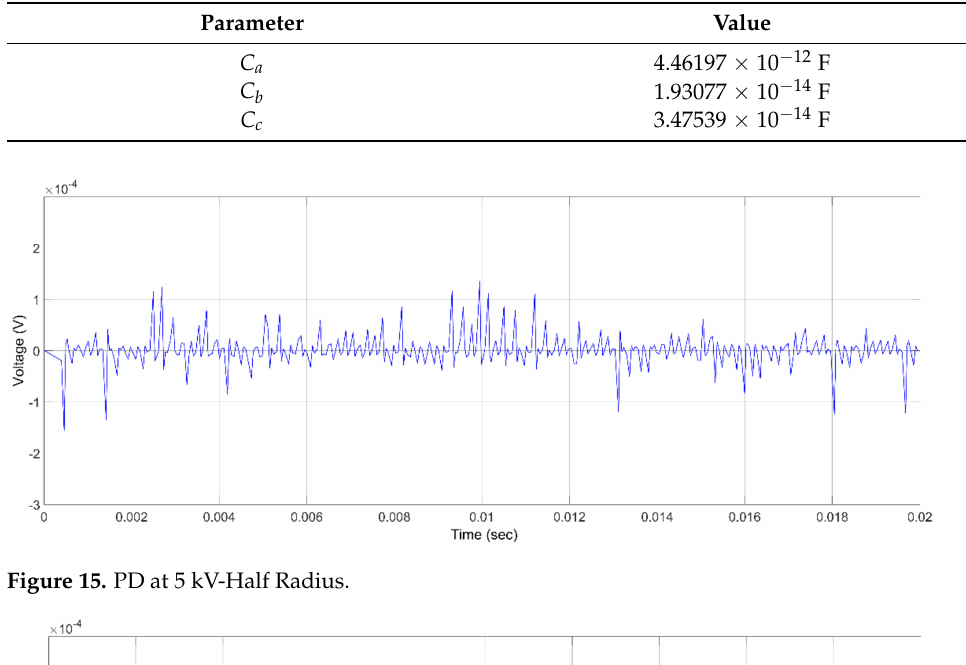
Table 3. Simulation Parameters (Epoxy Resin).